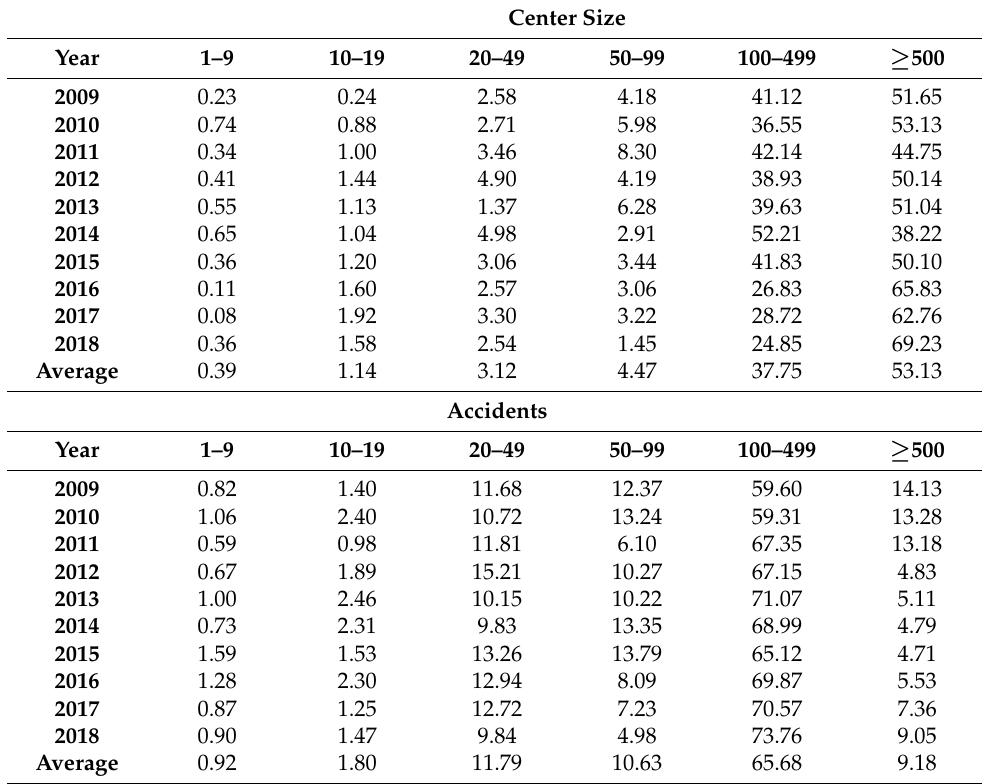
Table 4. Workers and accidents per size in UG (%).